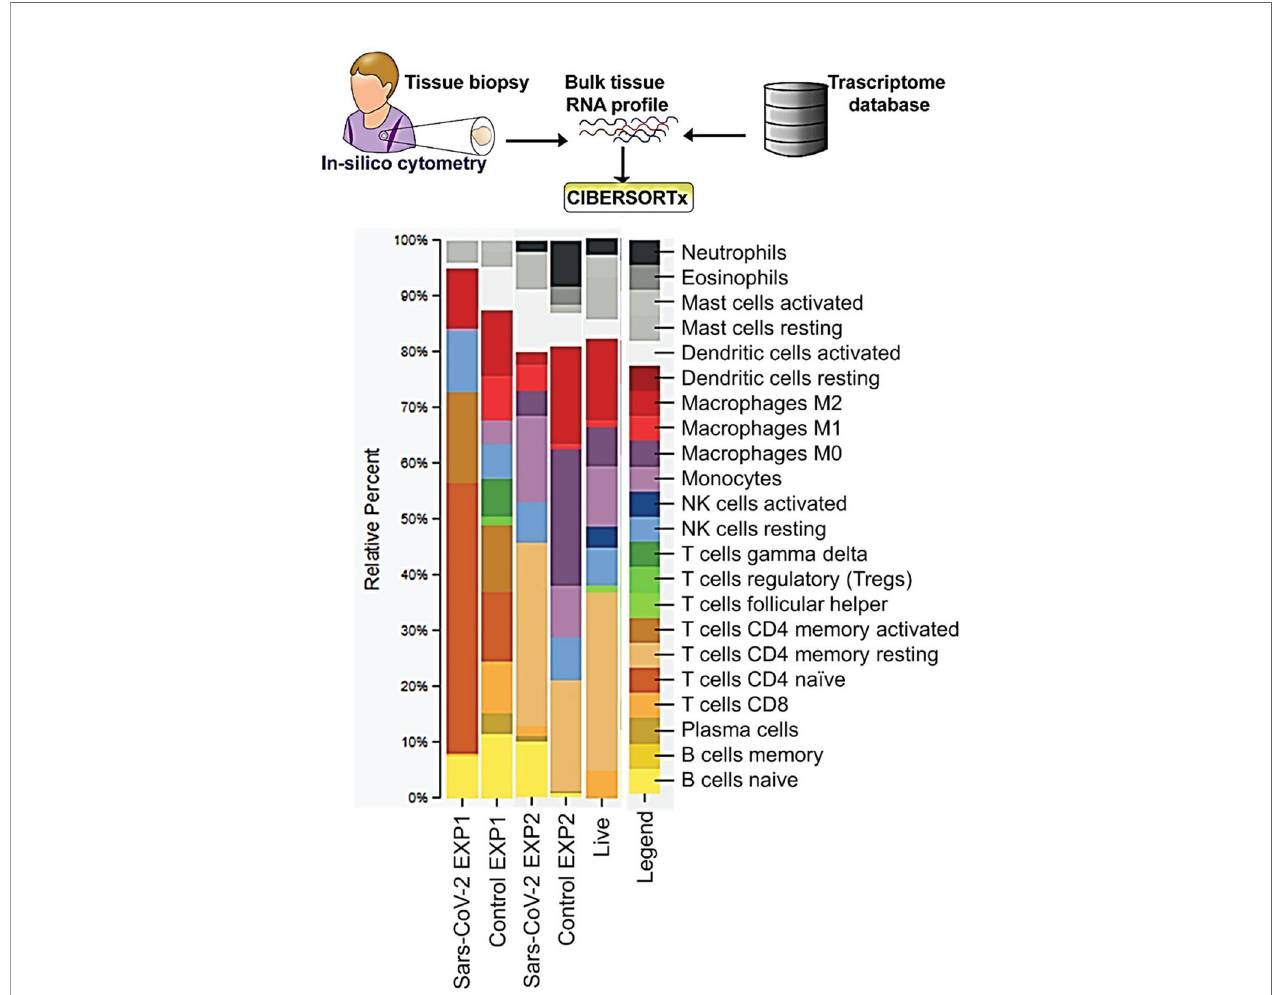
FIGURE 1 | CIBERSORT Analysis- Cell Fractions: This module enumerates the proportions of distinct cell subpopulations in bulk tissue expression pro fi les.